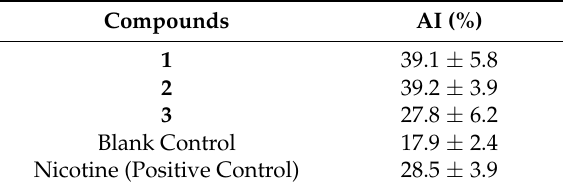
Table 2. Anti-feeding index (AI) of compounds 1 – 3 against to male fruit fly ( D. melanogaster